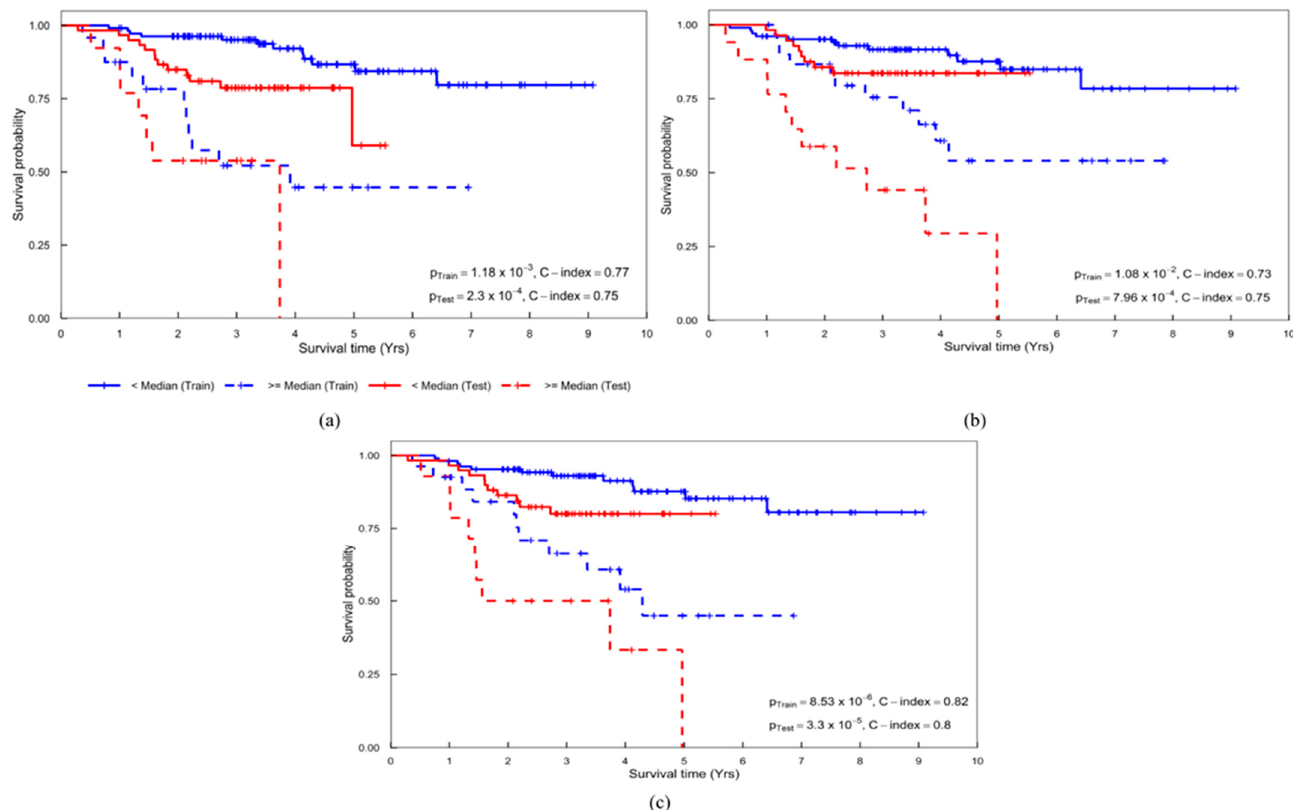
Figure 4. Kaplan–Meier curves obtained from the ( a ) clinical, ( b ) PH ‐ PET, and ( c ) clinical + PH ‐ PET signatures. PH ‐ PET: persistent homology ‐ positron emission tomography. signatures. PH-PET: persistent homology-positron emission